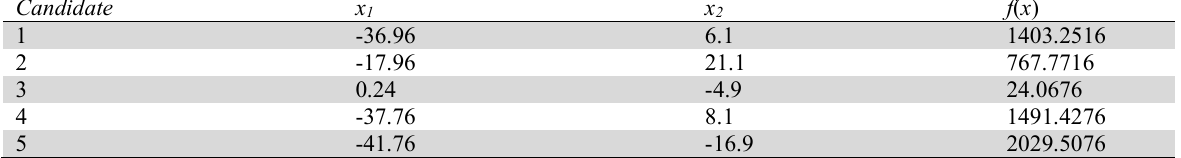
New values of the variables and the objective function during second iteration (Rao-1) Candidate